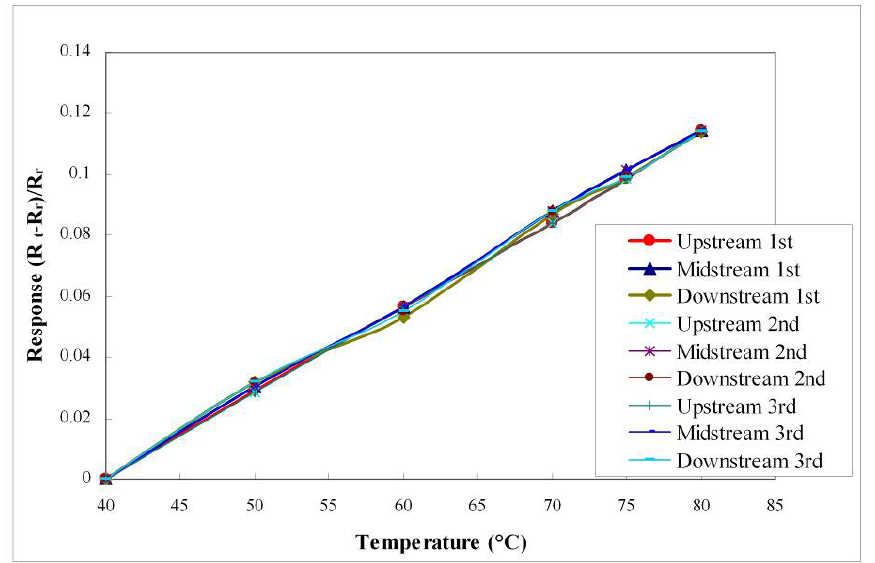
Figure 7. Calibration curves of micro temperature sensors upstream, midstream and downstream.